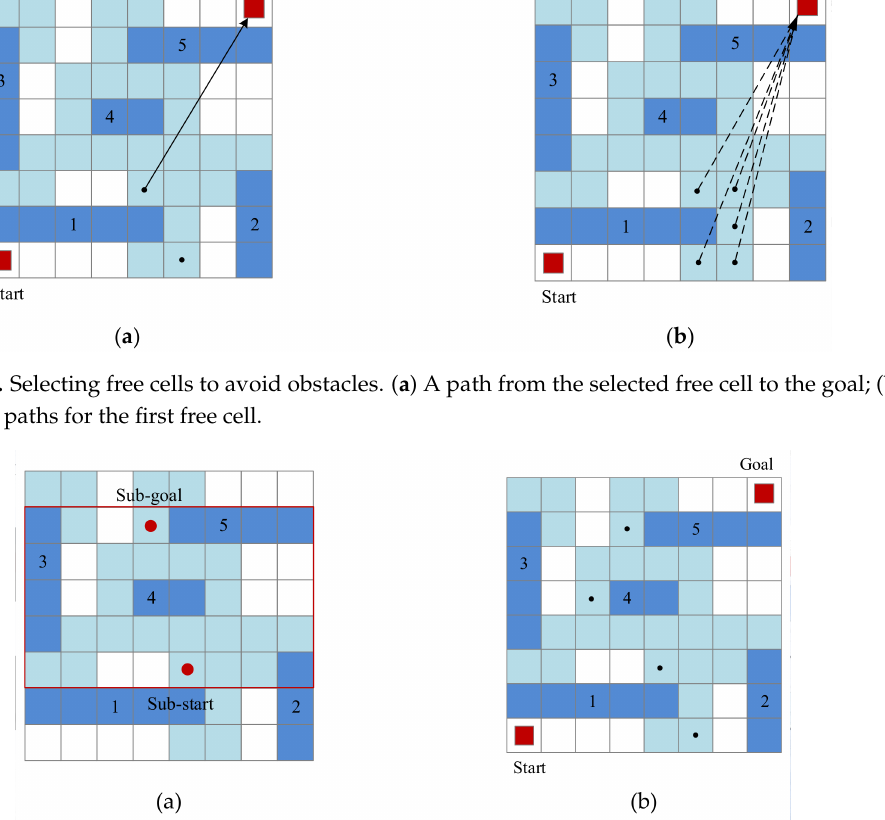
Figure 12. Generating sub-problems. ( a ) Defined sub-problem; ( b ) selected free cells for a feasible